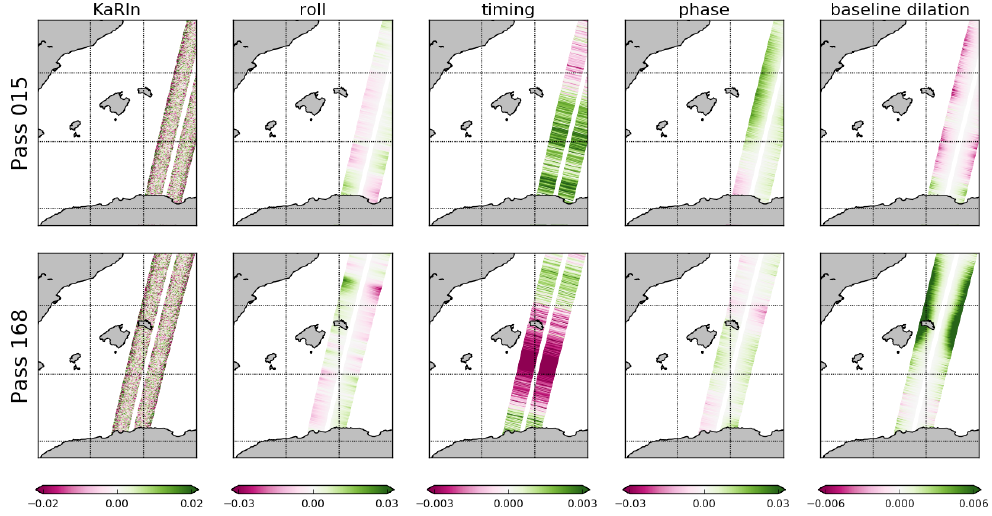
Figure A4. The different instrument noise types (m) for passes 15 and 168 over cycle 30 are